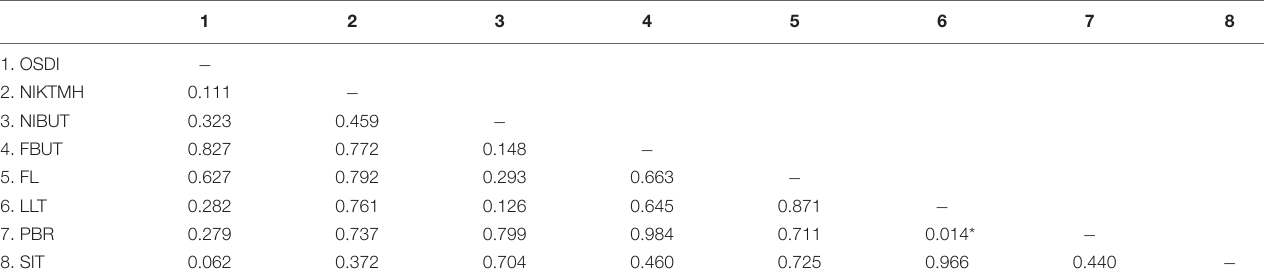
TABLE 6 | Intercorrelation between analyzed variables in patients aged 20–40.